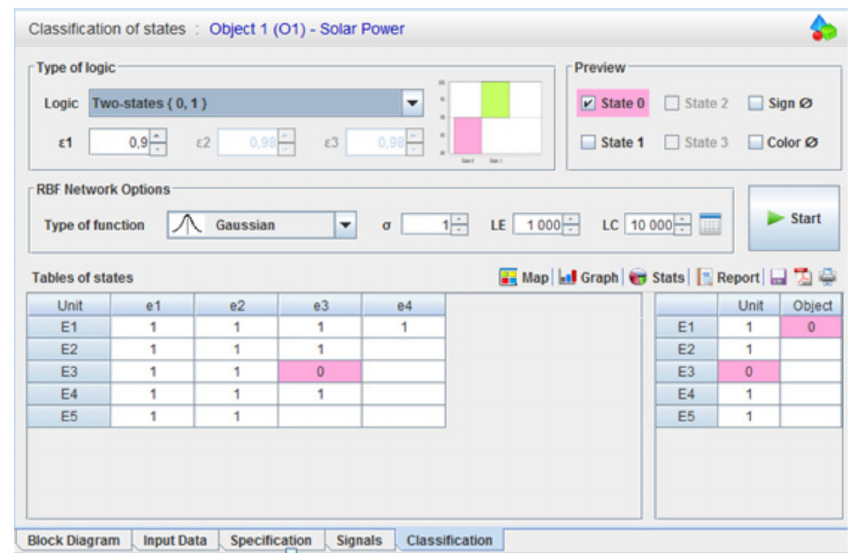
Figure 10. The result form of the DIAG 2 program “Table of states of L-PSPD” for